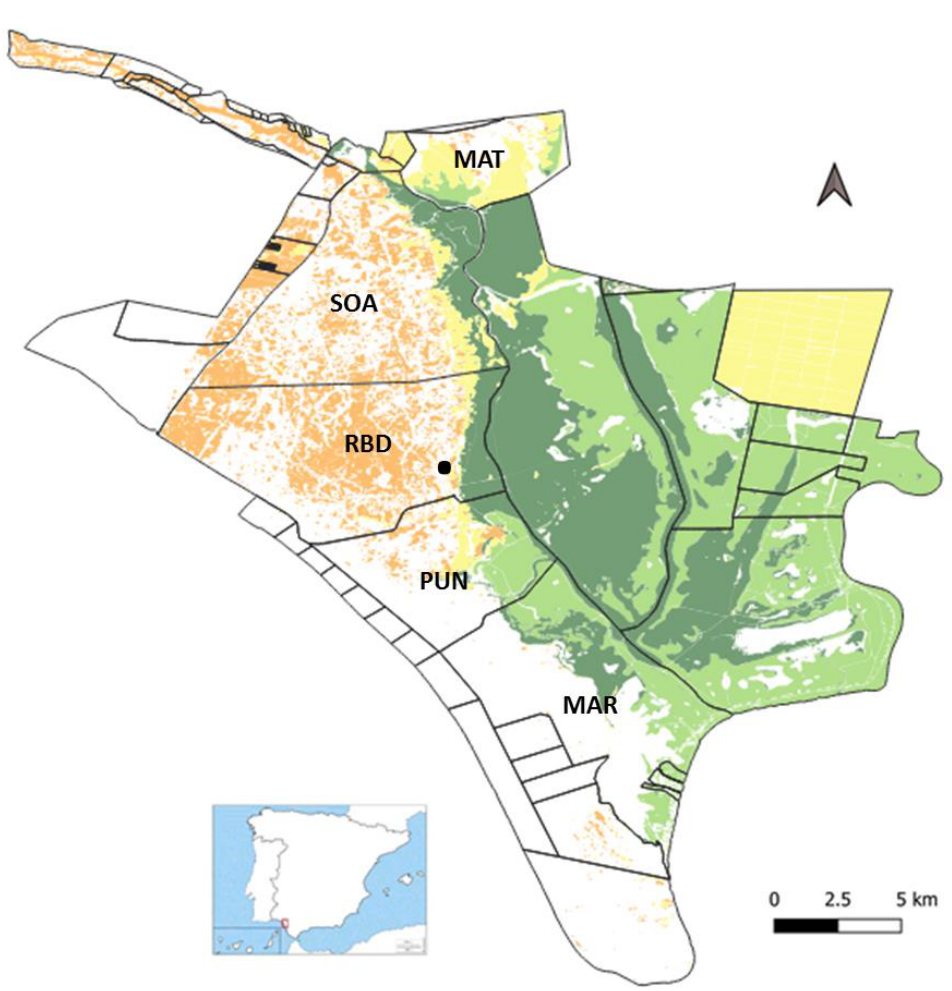
Figure 1. Distribution of the four vegetation types used in this study within the Doñana National Park. Black lines represent different management units (largely coinciding with property boundaries). Scrubland is shown in orange, grassland in yellow, saltmarsh in light green, and bulrush marshland in dark green. The acronyms refer to the names of the management units included in the study. The black dot indicates the location of the meteorological station. White areas indicate areas of bare soil, forest stands, or mixed vegetation (i.e., pixels where the dominant vegetation occupied less than 70% of the area) that were not used for the calculations of NDVI per vegetation type and management unit (as explained above).